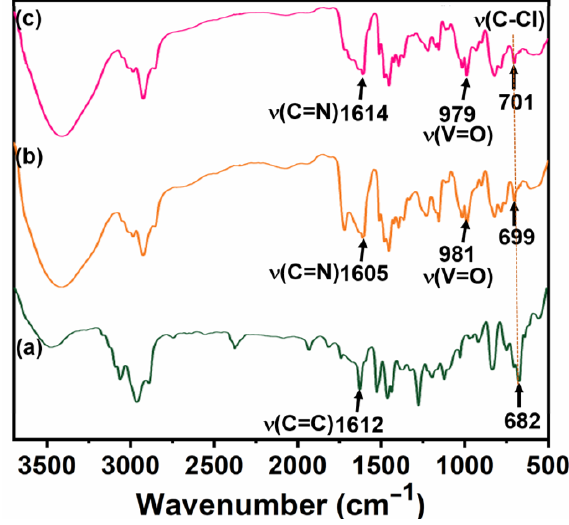
Figure 9. FT-IR spectra of ( a ) PS – Cl, ( b ) [V IV (acac)L 1 ]@PS ( 3 ) and ( c ) [V IV (acac)L 2 ]@PS ( 4 ).